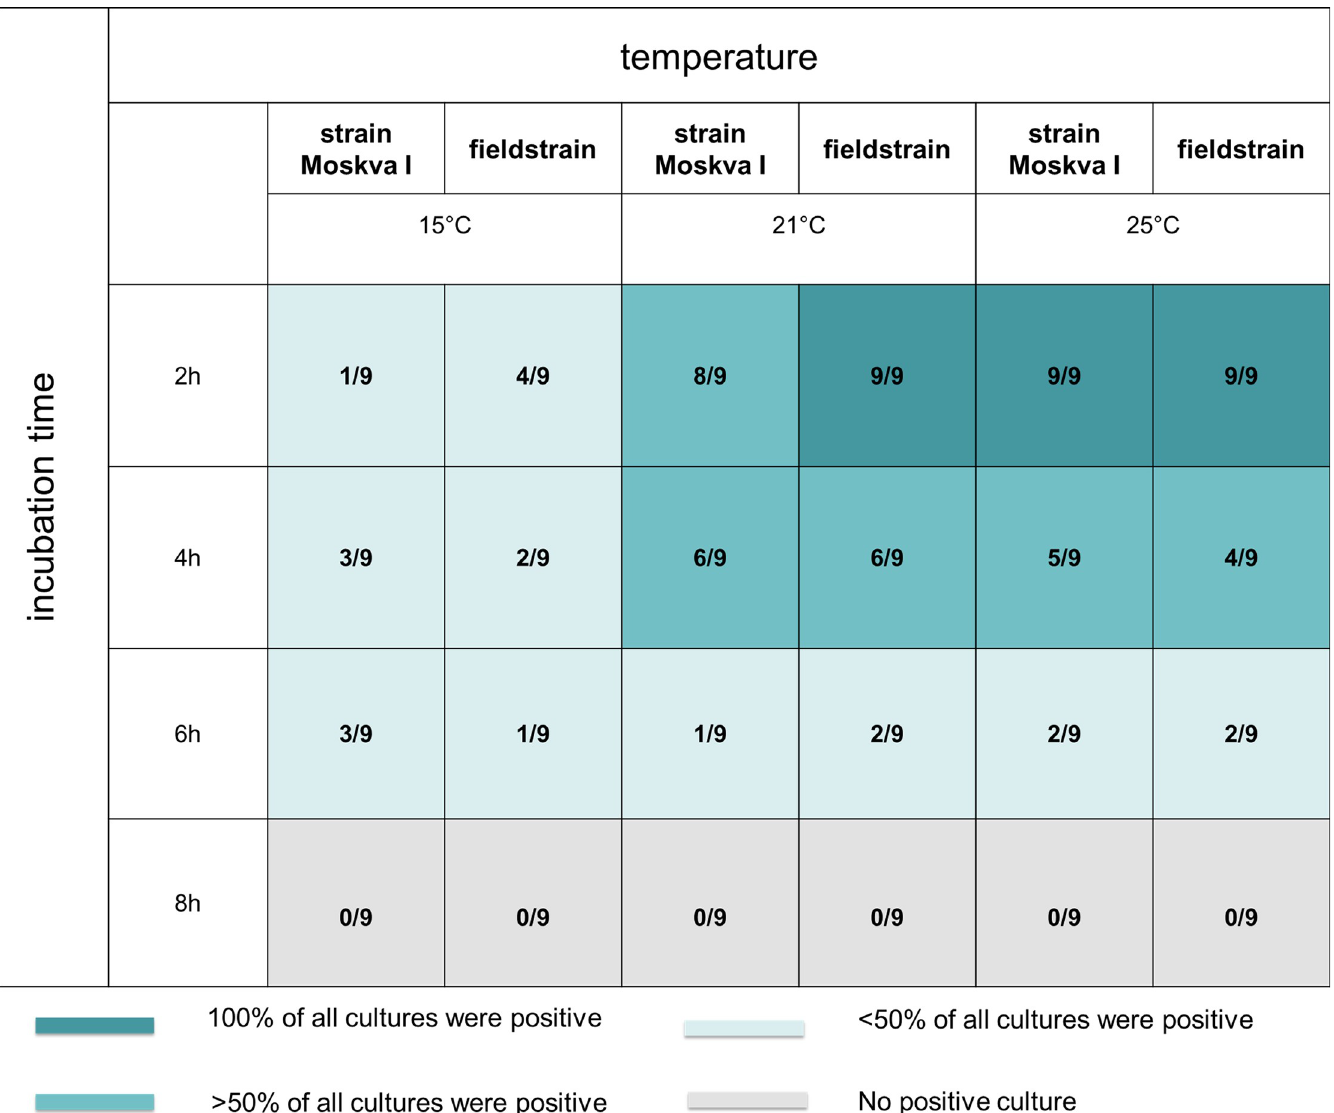
Fig 2. Survival of Leptospira kirschneri serovar Grippotyphosa strain Moskva V (reference strain) and the field strain (94-6/2007) after incubation on strawberries for different time-periods and at varying temperature examined by dark field microscopy of the cultures. Ratios in the cells depict the number of culture positive replicates per total number of